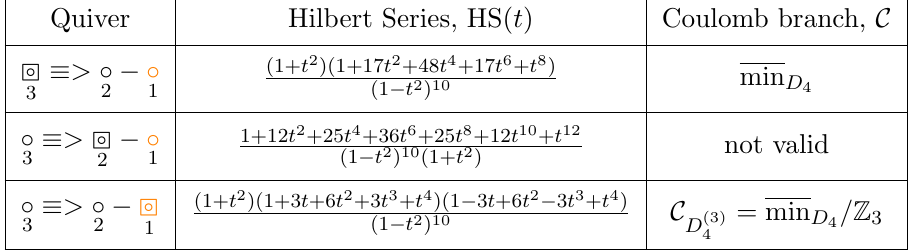
Table 6 . Ungauging schemes for the twisted a(cid:14)ne D (3)